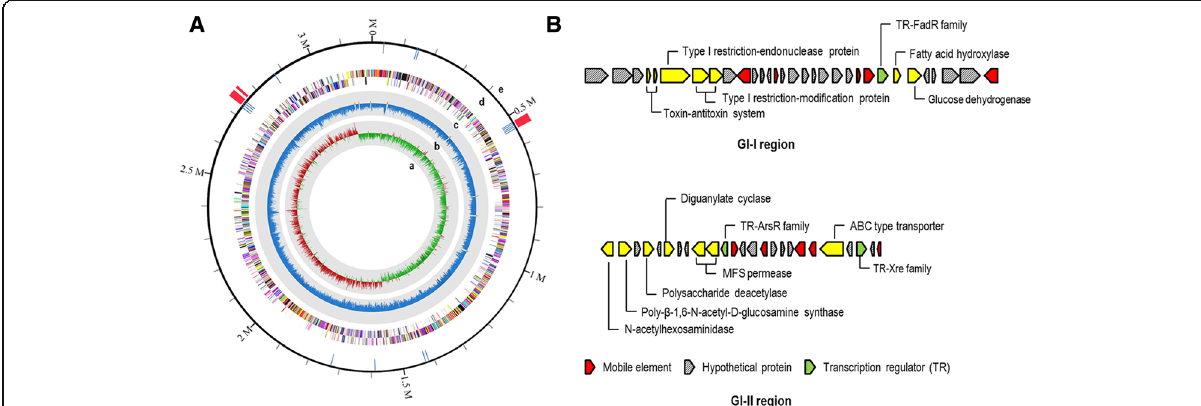
Fig. 3 A circular map of the genome of Planococcus sp. PAMC21323 ( a ) and gene cluster of genomic islands ( b ). Starting from the inner circle moving outwards, the following tracks are shown: Circle a, positive (red) and negative (green) GC skew; circle b, GC content; circle c, predicted